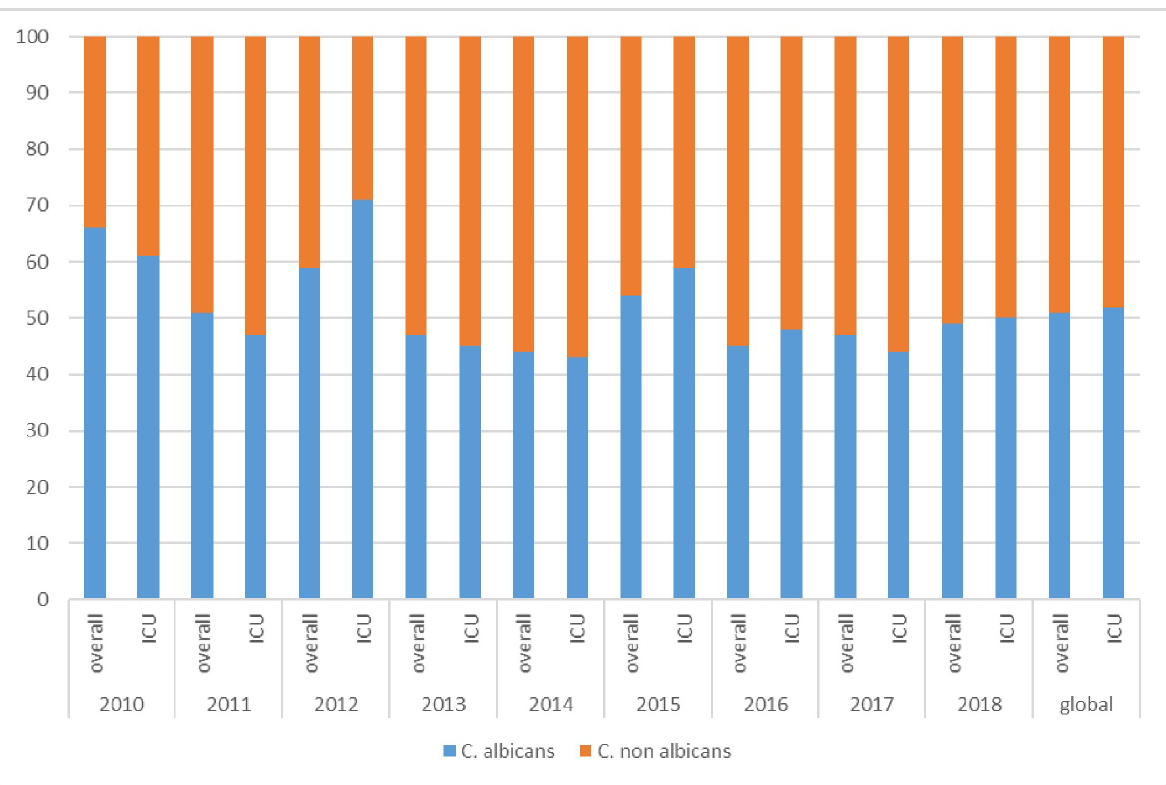
Fig 2. Ratio variation of Candida albicans /other Candida species isolation over nine years.